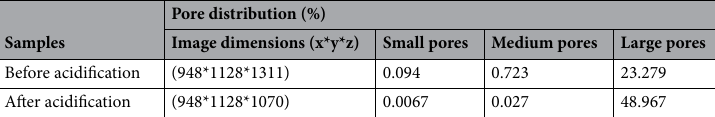
Table 4. Behavior of porosity distribution by particle size.